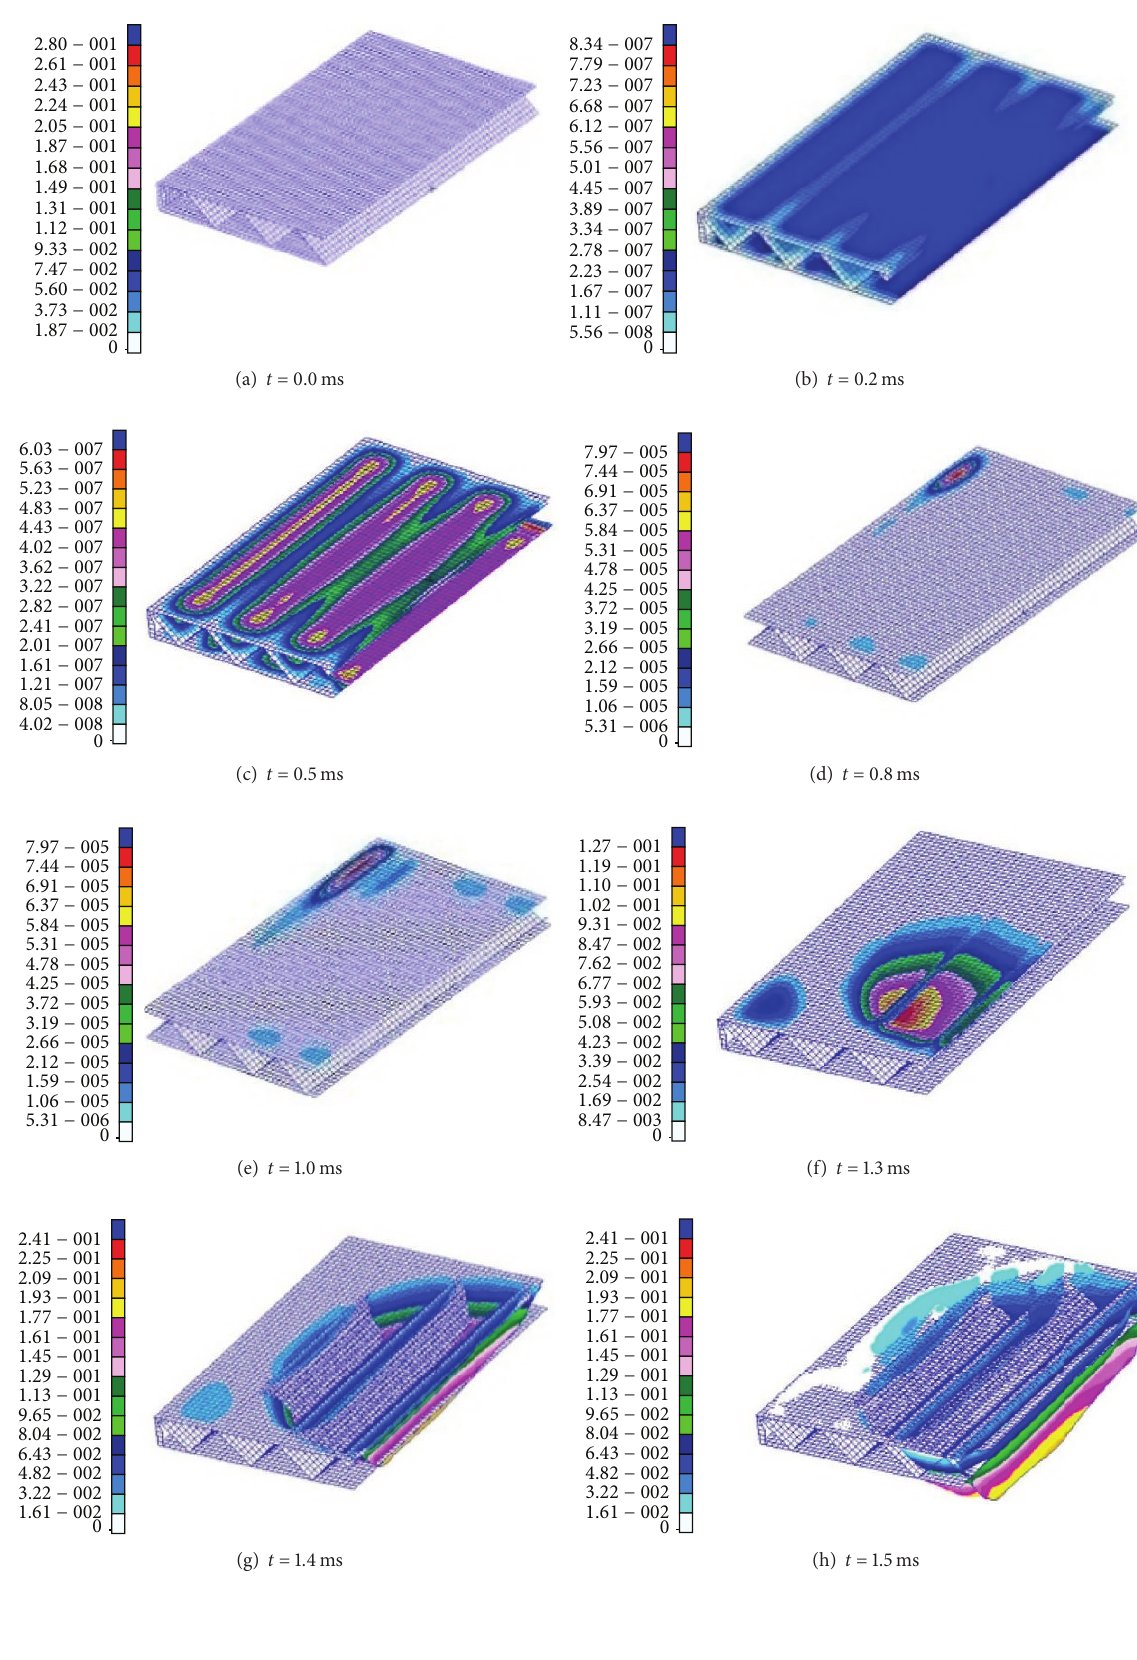
Figure 21: Deformation of case 3 ( W = 5.00 kg, d = 0.6